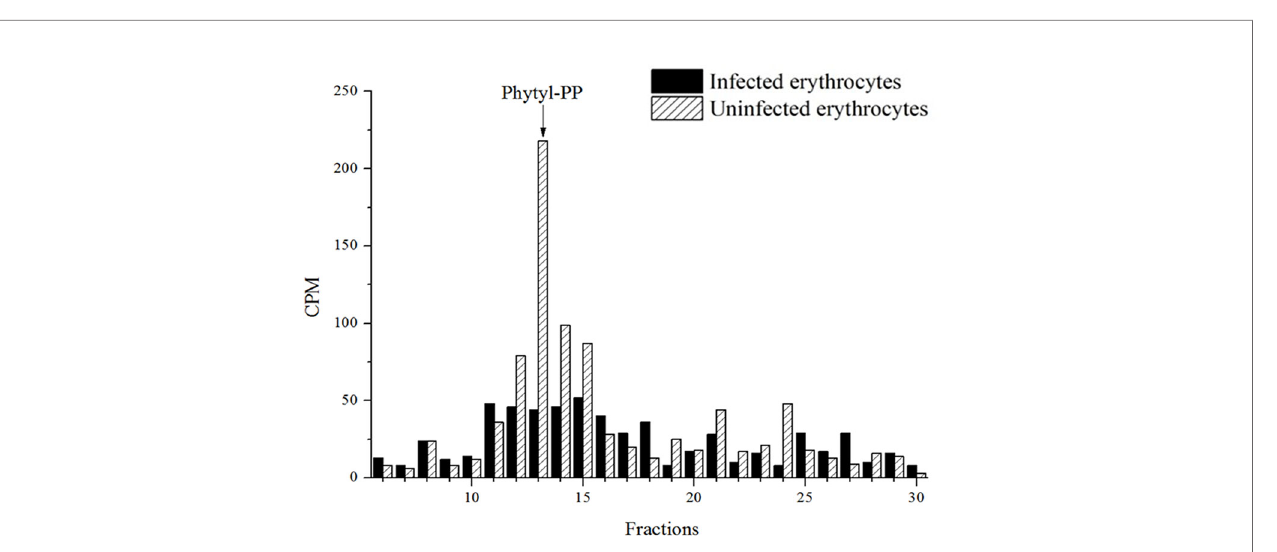
FIGURE 5 | [ 3 H]-GGPP radioactive incorporation pro fi le for P. falciparum and uninfected erythrocytes. Infected erythrocytes with mature forms and uninfected erythrocytes metabolically labeled with [ 3 H]-GGPP were subjected to extraction with n-butyl alcohol saturated with water as described for phytyl-PP extraction. The extracts were puri fi ed by RP-HPLC (system II). The experiment was performed twice with similar